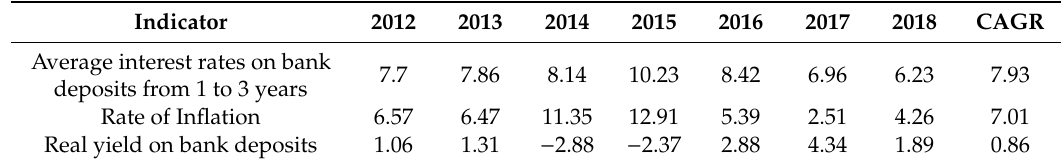
Table 4. Interest Rates on Bank Deposits of Individuals and the Inflation Rate in Russia, % per year.